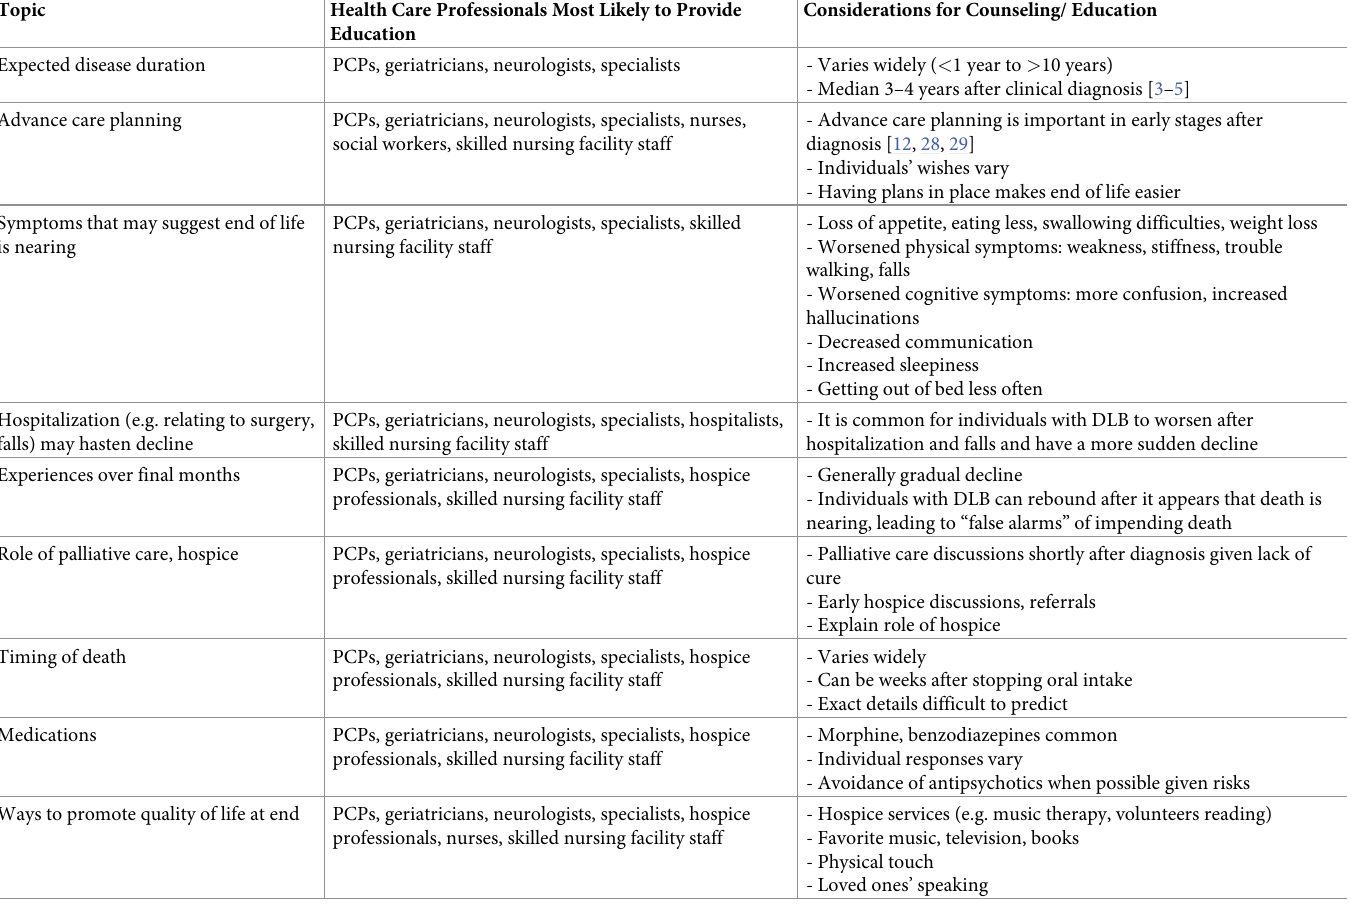
Table 3. Counseling and education topics regarding end of life in dementia with Lewy Bodes. Topic Health Care Professionals Most Likely to Provide